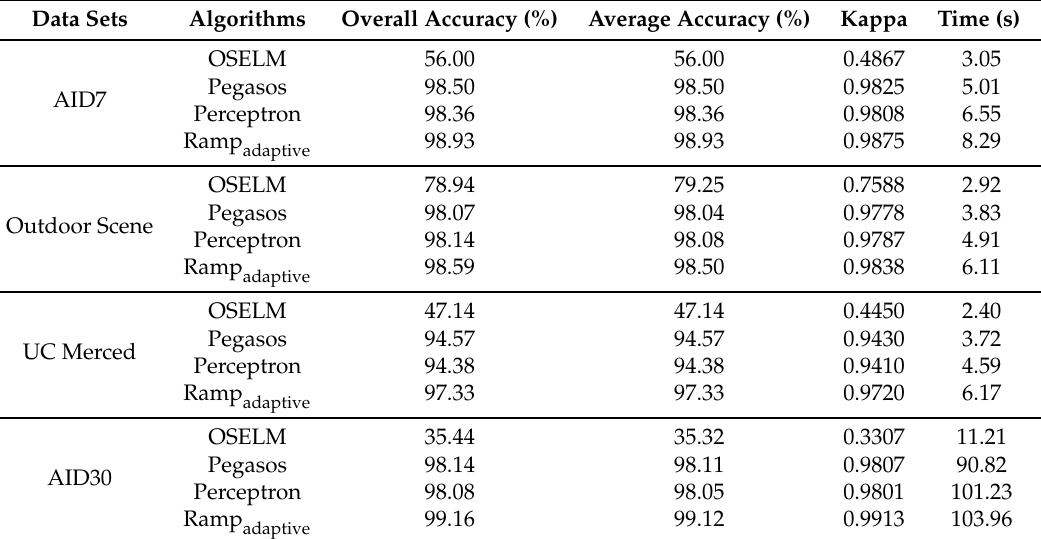
Table 2. Performance comparison of different algorithms.